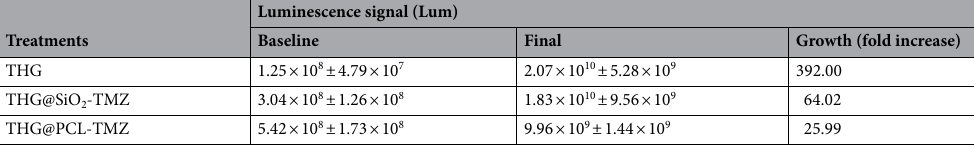
Table 2. The effect of the different treatments on tumor growth. The tumor growth is calculated as mean of bio-luminescence ± Standard Error of Mean (SEM) and displayed as fold increase [r Lum(tx)−Lum (t0)/Lum (t0) of light emission